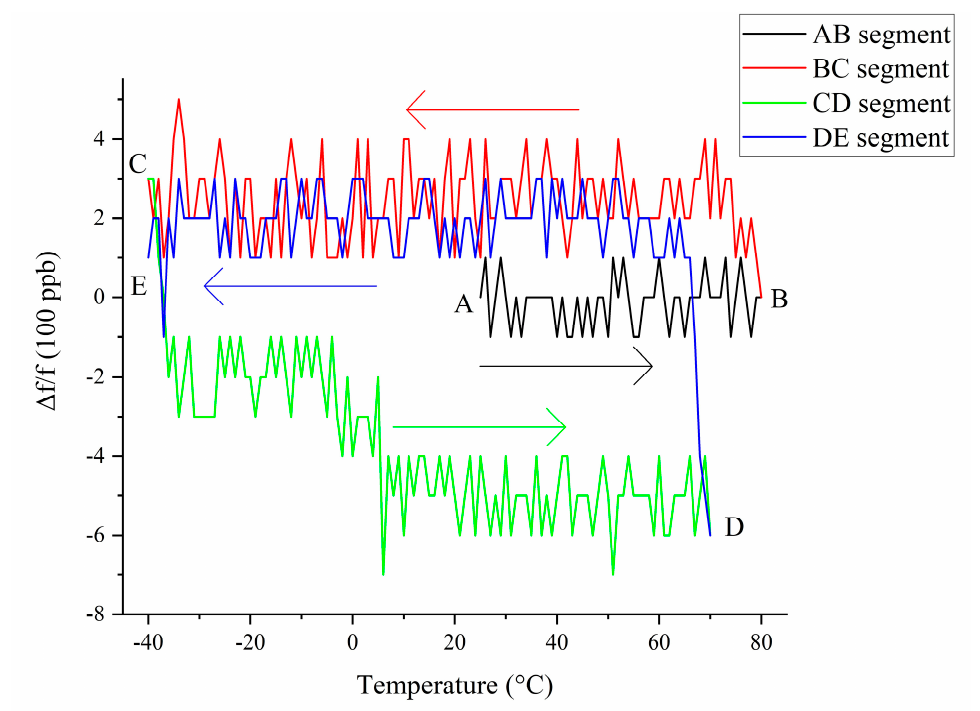
Figure 7. Original thermal hysteresis curve.